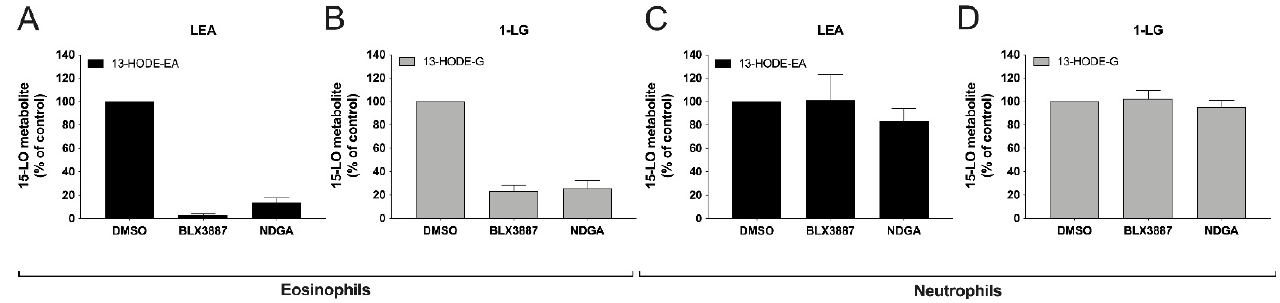
Figure 9. Inhibition of 13-HODE-G and 13-HODE-EA biosynthesis by 15-LO inhibitors in human eosinophils and neutrophils. Pre-warmed (37 ◦ C) human ( A , B ) eosinophil suspensions (10 6 cells/mL in HBSS containing 1.6 mM CaCl 2 ) or ( C , D ) neutrophil suspensions (5 × 10 6 cells/mL in HBSS containing 1.6 mM CaCl 2 ) were pre-treated with DMSO, BLX-3887 (10 µ M) or NDGA (10 µ M) for 5 min before the addition of 3 µ M ( A , C ) LEA or ( B , D ) 1-LG. Incubations were stopped 5 min after LEA or 1-LG treatment by the addition of one volume of cold ( − 20 °C) MeOH containing the internal standards. Samples then were processed for LC-MS/MS analyses as described in methods. Results are the mean (±SEM) of 4 independent experiments.